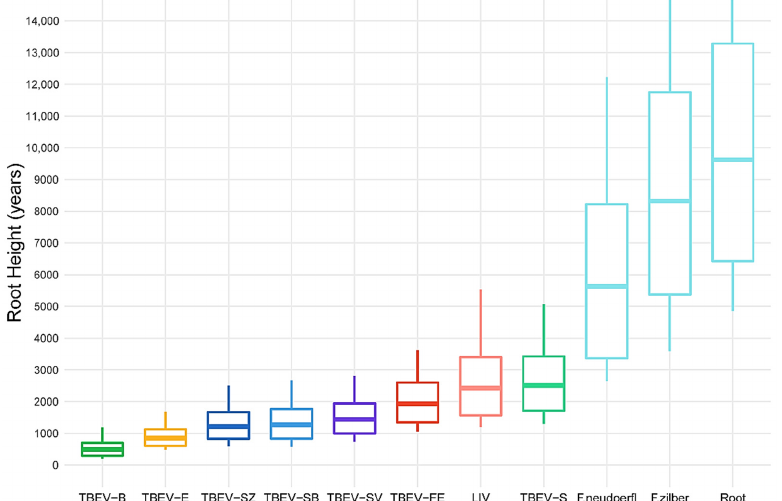
Figure 5. Boxplots of tick ‐ borne encephalitis virus (TBEV) subtype ages in years before the most recent sample (2 June 2021). The X ‐ axis is labeled by subtypes of TBEV: Baikalian ( ‐ B), European ( ‐ E), Siberian ( ‐ S) with Zausaev ( ‐ SZ), Baltic ( ‐ SB), and Vasilchenko ( ‐ SV) subgenotypes, Far ‐ Eastern ( ‐ FE), also with louping ‐ ill virus (LIV), Flavivirus neudoerfl, and Flavivrus zilber clades. The root is the common clade of TBEV (TBEV ‐ common). The edges of boxplots indicate 95% highest posterior density (HPD) intervals. The upper limit of F. neudoerfl , F. zilber, and root ages are restricted for convenience.